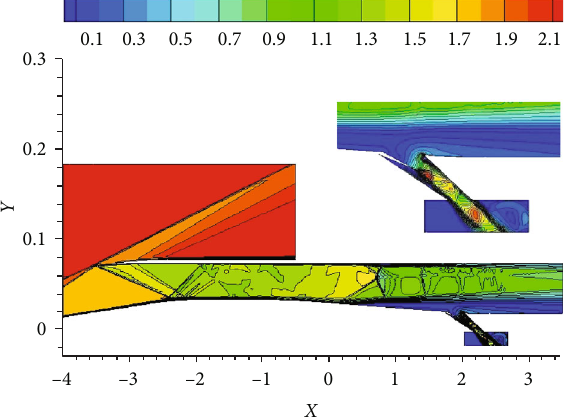
Figure 7: Mach number fl ow fi eld in